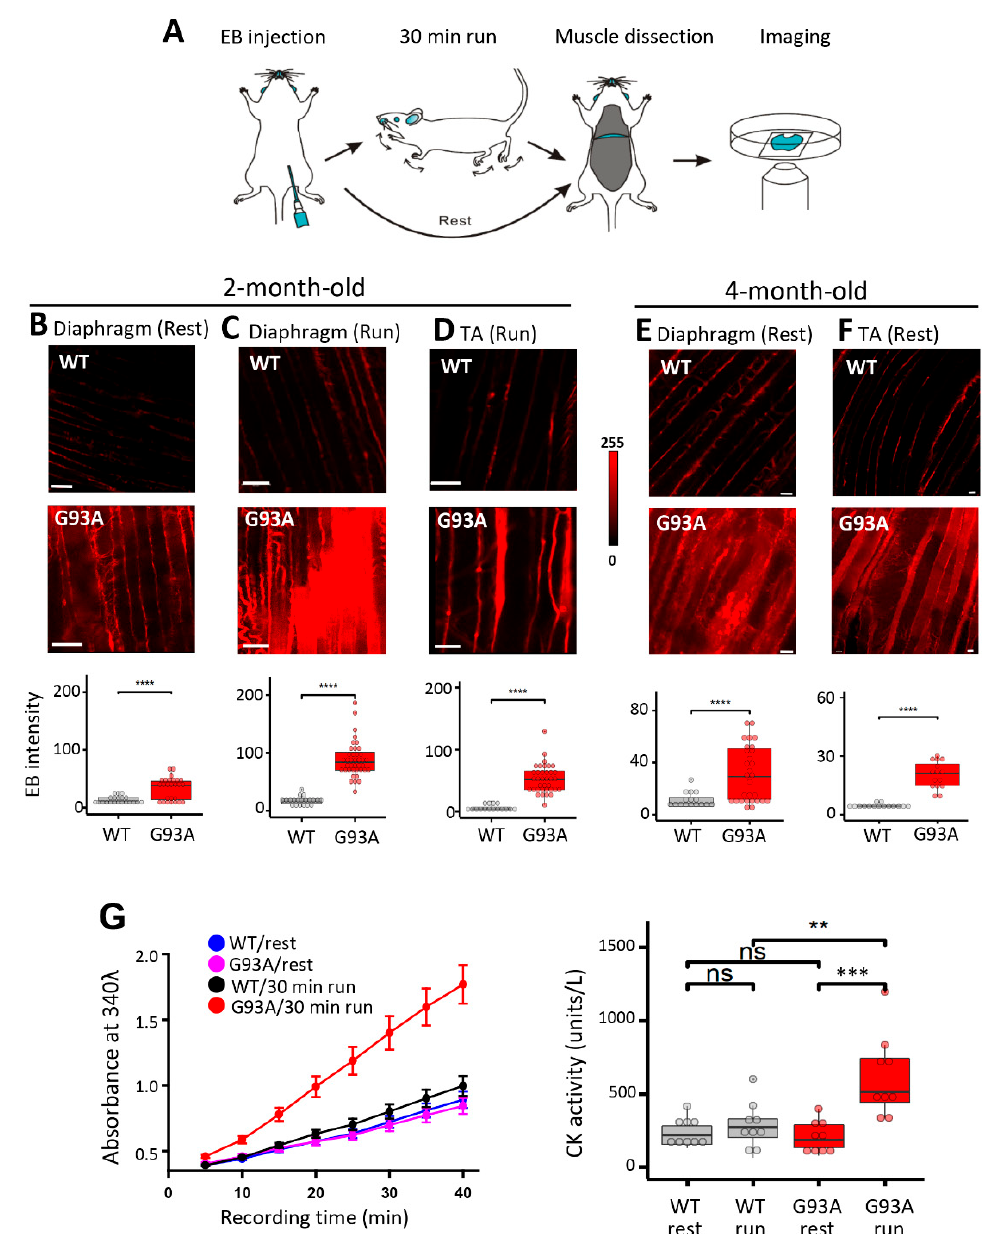
Figure 1. Diaphragm susceptibility to membrane injury is an early pathological event in ALS. ( A ) Schematic diagram for evaluation of diaphragm integrity in ALS mice. ( B ) Compared with WT mice, diaphragm muscles derived from G93A littermates (2-month-old) showed increased EB intensity at rest (WT: 12.8 ± 1.5, n = 21 from 4 mice; G93A: 33.4 ± 3.7, n = 26 from 2 mice, **** p < 0.0001). Scale bars: 20 μ m. ( C ) 30 min downhill running caused drastic elevation of EB in diaphragm derived from the G93A mice (WT17.30 ± 1.69, n = 20 from 3 mice; G93A: 88.49 ± 4.92, n = 39 from 4 mice, **** p < 0.0001). ( D ) 30 min downhill running also caused elevation of EB accumulation in G93A TA muscle (WT: 5.37 ± 1.13, n = 16 from 2 mice vs G93A: 52.40 ± 3.83, n = 36 from 3 mice, **** p < 0.0001). ( E ) Evaluation of EB accumulation in G93A diaphragm muscle of 4-month-old G93A mice at rest (G93A: 31.1 ± 4.0, n = 29 from 3 mice vs WT: 10.9 ± 1.6, n = 16 from 2 mice, *** p < 0.001). Scale bars: 20 μ m. ( F ) Evaluation of EB accumulation in TA muscle of 4-month-old G93A mice at rest (WT: 4.46 ± 0.27, n = 15 from 2 mice vs G93A: 20.18 ± 1.77, n = 15 from 3 mice, **** p < 0.0001). ( G ) Quantification of CK activity in serum samples of G93A and WT littermate mice (2-month-old) before and after 30 min running. n = 9 for each group, ** p < 0.01, *** p < 0.001, ns: not significant. Left panel shows the time-dependent reading of the absorbance (at 340 nm) of serum samples in a 96-well plate; Right panel shows the calculated CK activity derived from the absorbance reading (see Materials and Methods section). Scale bars: 20 µ